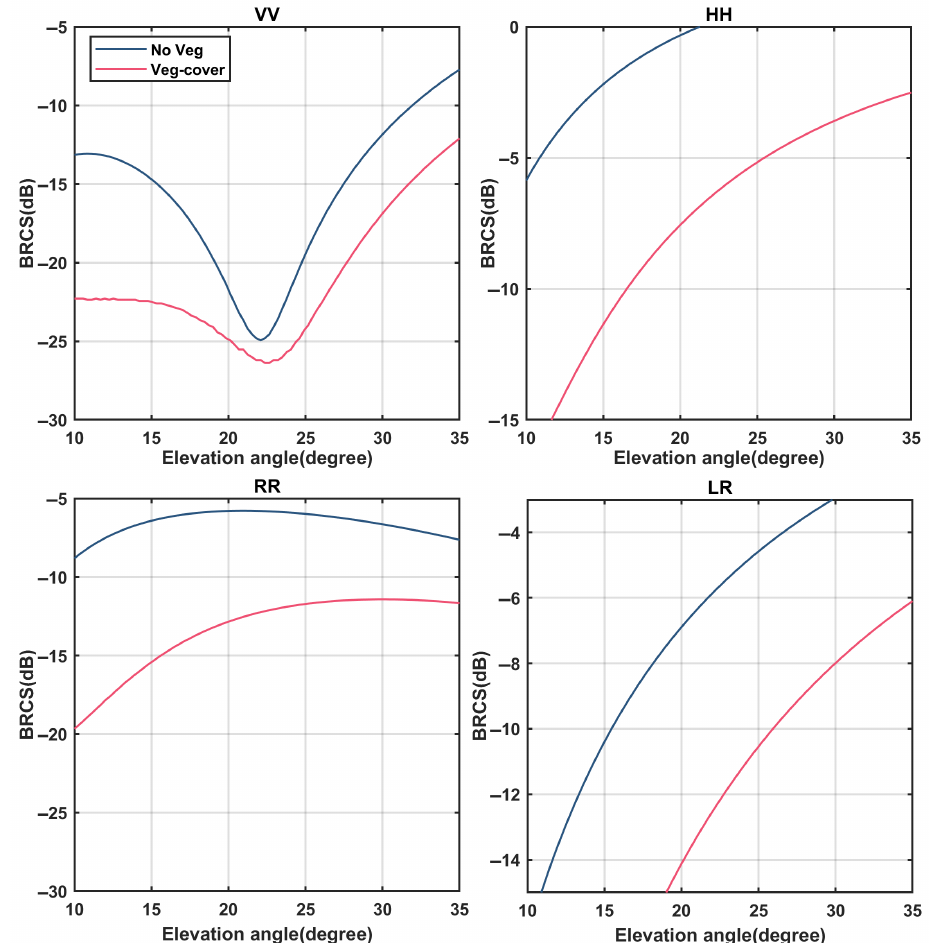
Figure 11. Variation of BRCS with elevation angles with and without vegetation cover under various